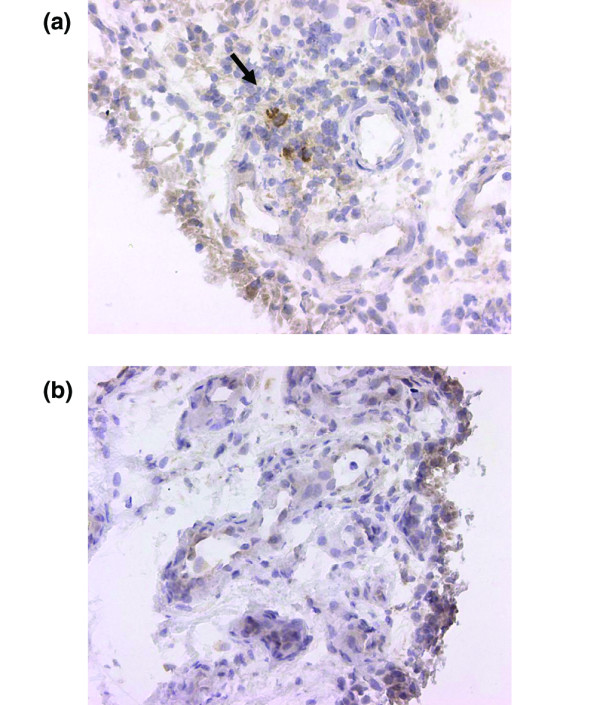
TNF-producing cells in a patient with RA with a subsequent good response to infliximab. Sections of synovial biopsy tissue from patient no. 6 before (a) and after (b) treatment with infliximab show diaminobenzidine staining (haematoxylin counterstained) for TNF neutralizing antibodies mAb1 and mAb11. Original magnification × 250.